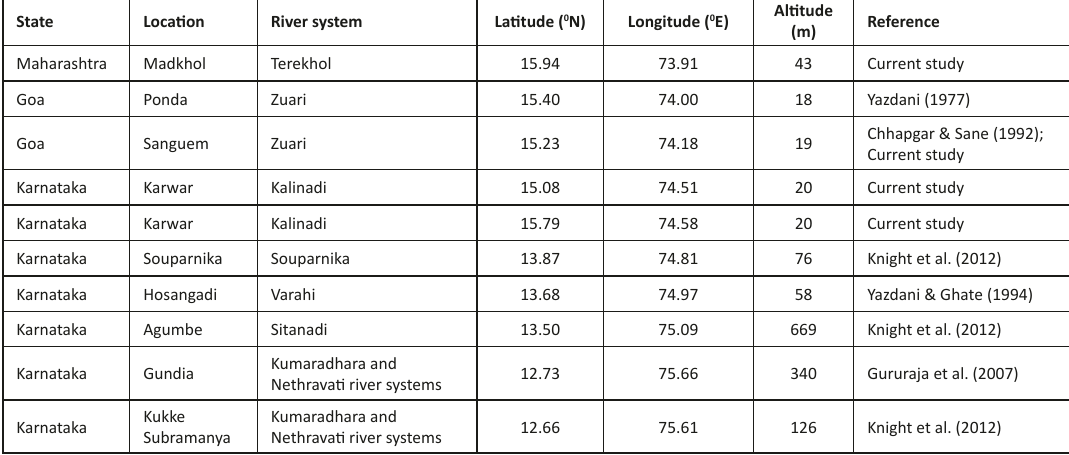
Table 3. Distribution of Pethia setnai . Latitude and longitude data is approximated using Google Earth from the locality details available in the references. State Location River system Latitude ( 0 N) Longitude ( 0 E)